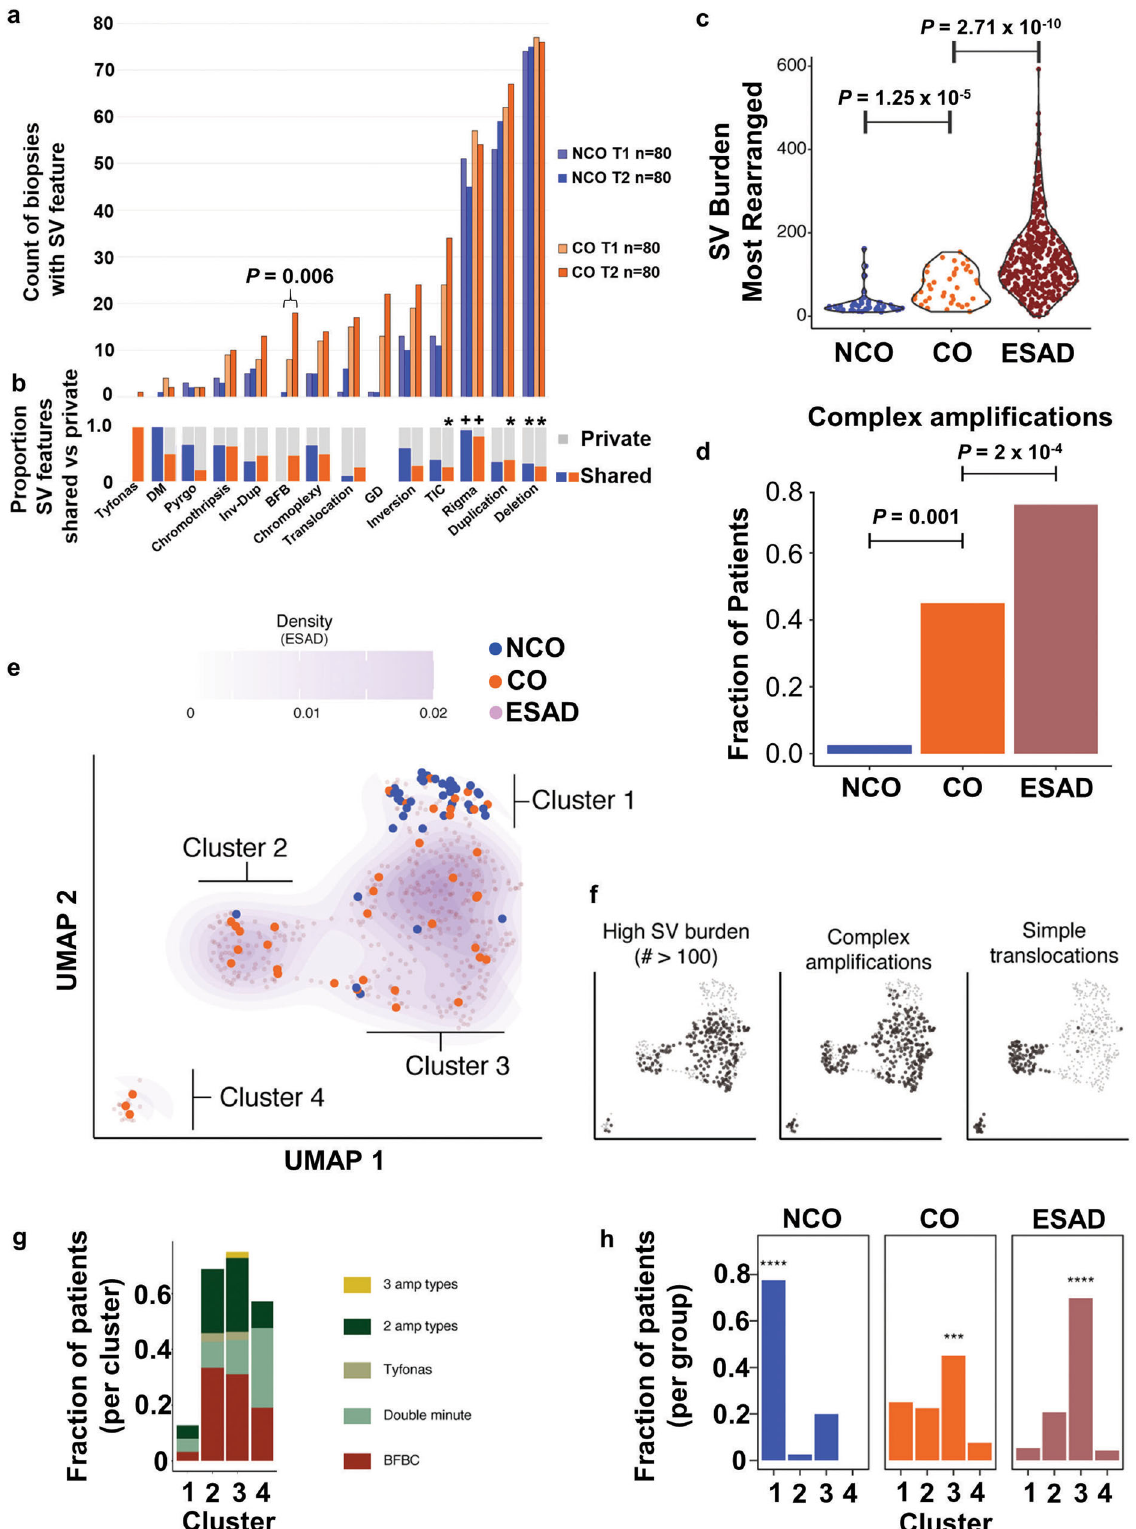
one-hit TP53 with chromosome 18:18 – 25 Mb gain and PCDH17 ) classi fi ed 38 out of 40 CO patients and 38 out of 40 NCO patients accurately ( fi ve-fold cross-validation mean 0.89 and 0.94 with 95% con fi dence interval 0.64 to 1, and 0.78 to 1, respectively),